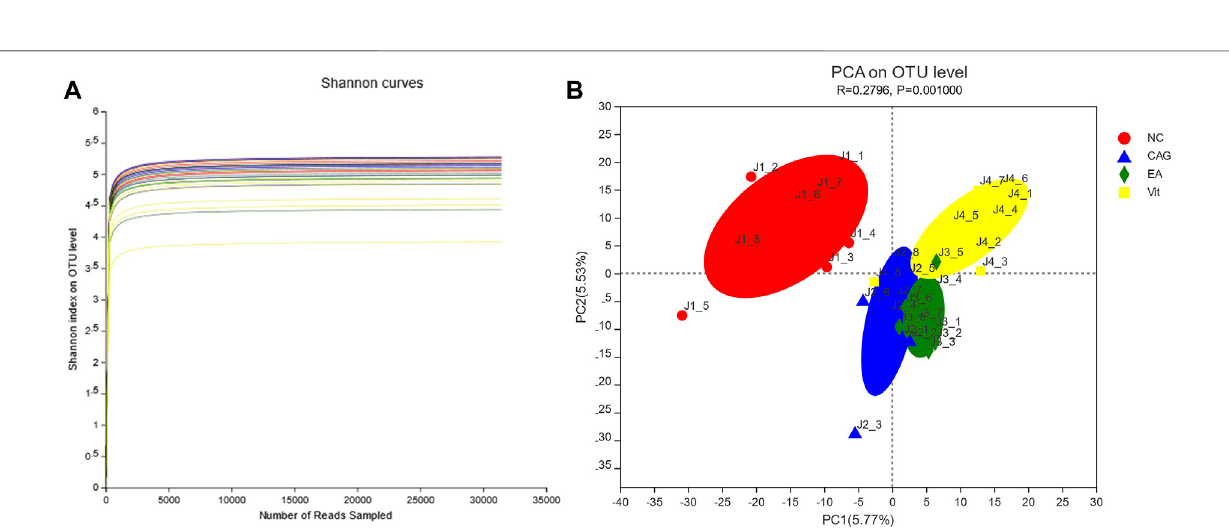
FIGURE 4 | Dilution curve. (A) Shannon index of rat intestinal fl ora. (B) PCA of rat intestinal fl